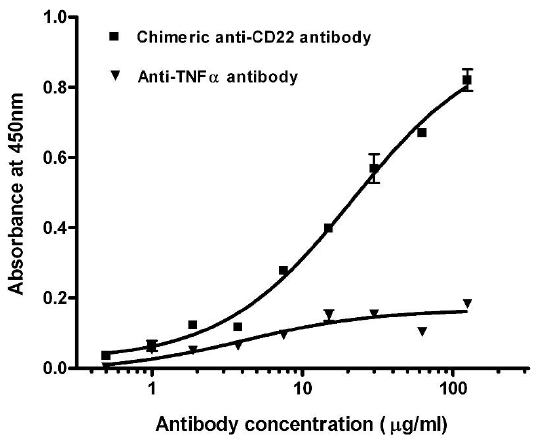
Figure 1. Titration curves of antibodies in binding assay against membrane antigens. Total soluble membrane proteins of Raji cells were used to detect chimeric anti-CD22 antibody ( ■ ) and anti-TNF α antibody ( ▼ ). The averages of samples were plotted against antibody concentration. Table 1. Summary of intra-assay and inter-assay variability of EC50 of chimeric anti-CD22 antibodies.